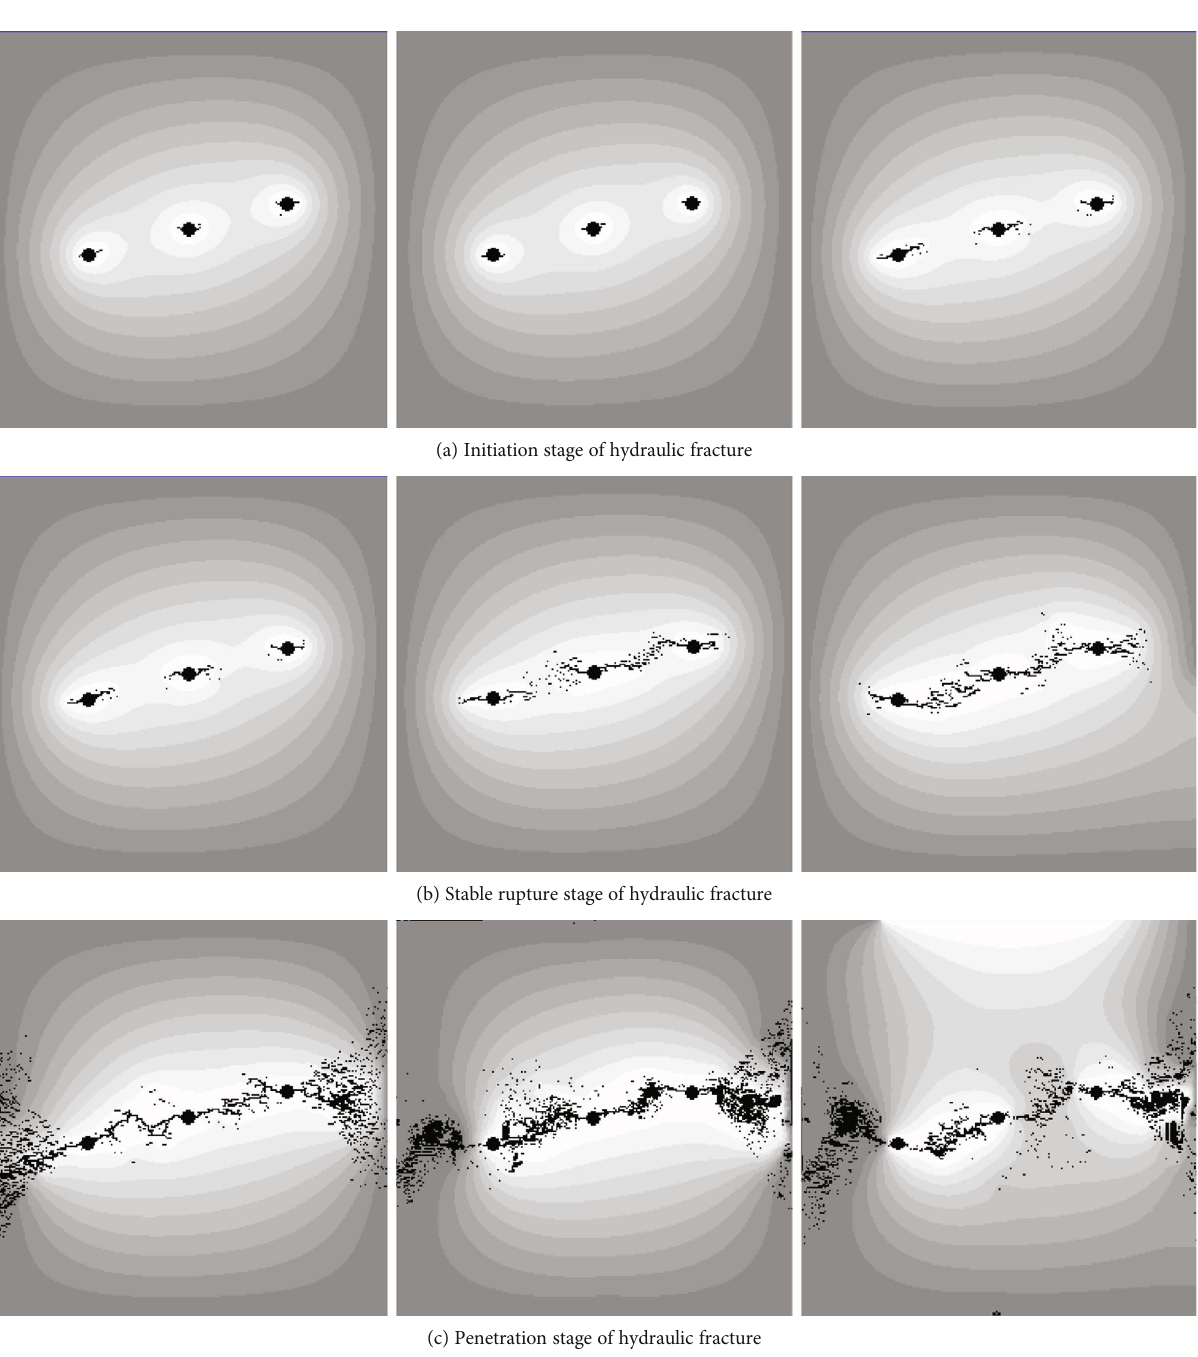
Figure 5: Initiation, propagation, and penetration process of multihole linear codirectional fractures at di ff erent principle stress di ff erences: Δσ = 2 MPa, Δσ = 3 MPa, and Δσ = 4